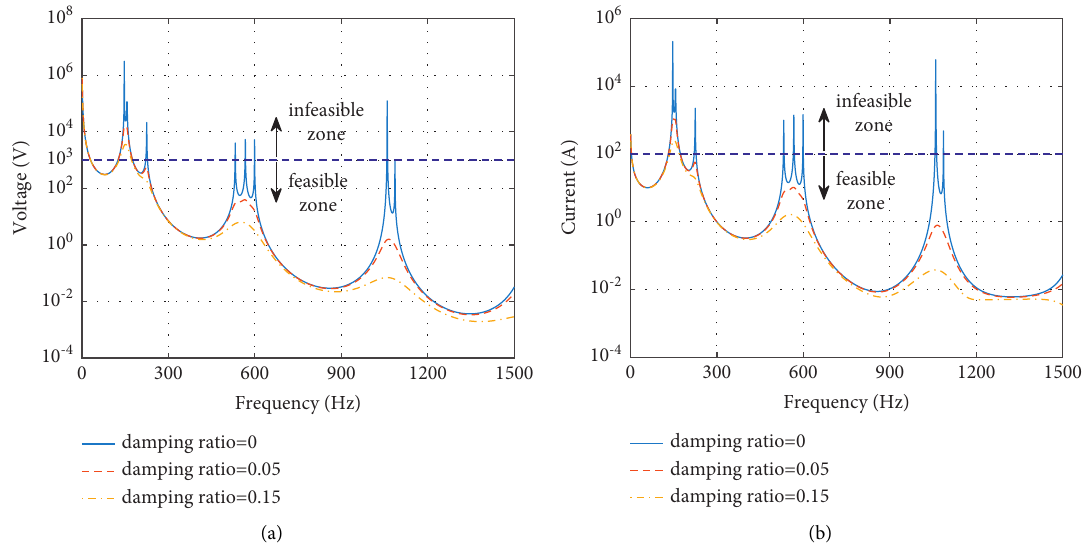
Figure 14: Voltages and currents of PSPS with different damping loss factors, (a) Required voltages of the piezoelectric stacks under active, (b) Required currents of the piezoelectric stacks under active control.